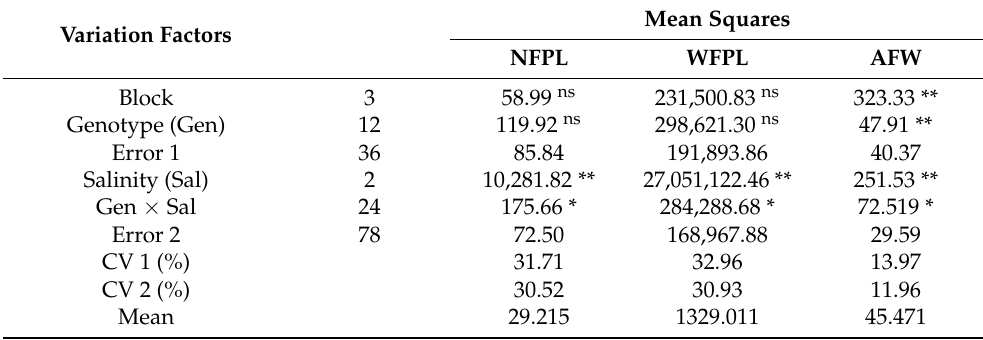
Table 4. Summary of analysis of variance of number of fruits per plant (NFPL), weight of fruits per plant (WFPL) (g plant − 1 ), and average fruit weight (AFW) (g fruit − 1 ) of combinations of ‘Tahiti’ acid lime ( Citrus × latifolia (Yu. Tanaka) Tanaka) with 13 rootstocks 270 days after the onset of saline water irrigation. Mean Squares Variation Factors NFPL WFPL AFW Block 3 58.99 ns 231,500.83 ns 323.33 ** Genotype (Gen) 12 119.92 ns 298,621.30 ns 47.91 ** Error 1 36 85.84 191,893.86 40.37 Salinity (Sal) 2 10,281.82 ** 27,051,122.46 ** 251.53 ** Gen × Sal 24 175.66 * 284,288.68 * 72.519 * Error 2 78 72.50 168,967.88 29.59 CV 1 (%) 31.71 32.96 13.97 CV 2 (%) 30.52 30.93 11.96 Mean 29.215 1329.011